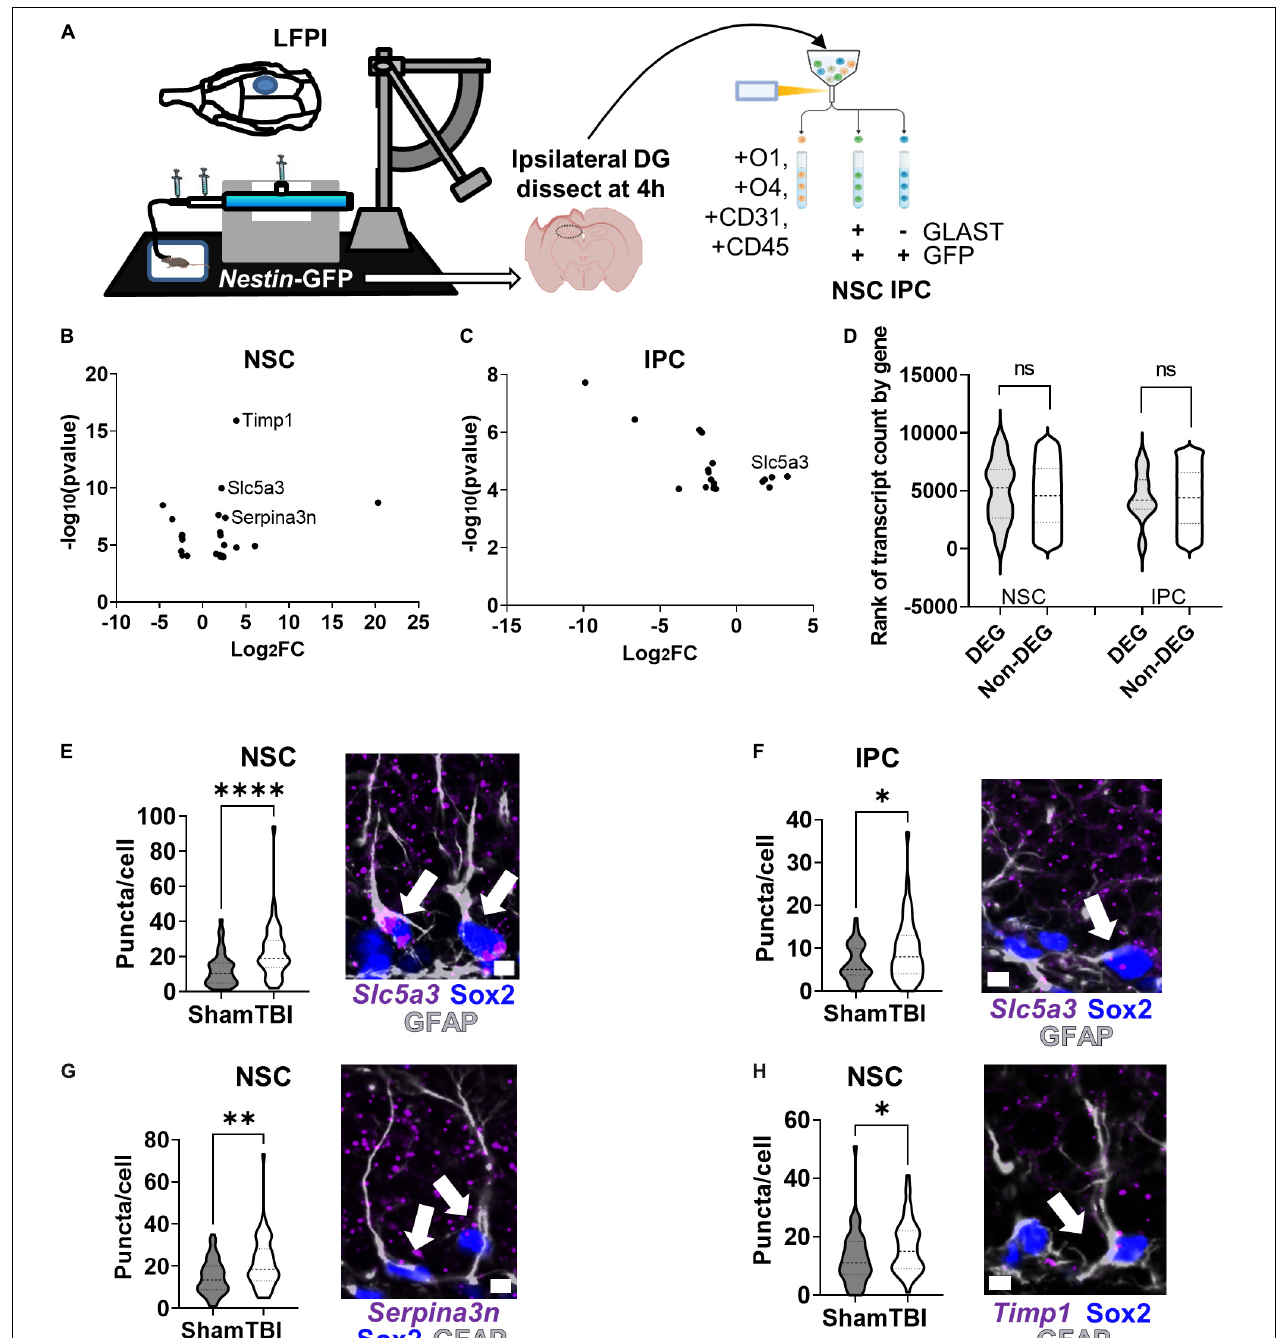
FIGURE 6 | RNAseq and CLEAR filtering enable accurate DEG identification in NSCs and IPCs in mice with lateral fluid percussive brain injury (LFPI). (A) Mice ( n = 3 per group) were given lateral fluid percussive injuries or sham treatment. Four hours after injury, DGs from the ipsilateral side of the brain were isolated and processed for RNAseq as described in Figure 5A . (B) Volcano plot of DEGs identified in NSCs after LFPI. (C) Volcano plot of DEGs identified in IPCs after LFPI. (D) Violin plot of TBI DEG and non-DEG transcript count level distribution in NSCs and IPCs. ns, not significant, Mann–Whitney test. (E) Quantification of Slc5a3 mRNA via RNAscope in NSCs (identified via GFAP + SOX2+ immunolabeling) confirmed upregulation after TBI (left). Representative image with arrows pointing to NSCs with Slc5a3 expression (right). (F) Quantification of Slc5a3 mRNA in IPCs similarly confirmed increased expression after LFPI (left). Representative image with arrow pointing to IPC with Slc5a3 expression (right). (G) Quantification of Serpina3n mRNA in NSCs also confirmed upregulation after LFPI (left). Representative image with arrow pointing to NSC with Serpina3n expression (right). (H) Quantification of Timp1 mRNA in NSCs also showed increased expression after LFPI (left). Representative image with arrow pointing to NSC with Timp1 expression (right). (E–H) Mean ± SEM of mean RNA puncta per cell with n = 50 cells per group from 5 mice, Mann–Whitney t -test, ∗ p < 0.05, ∗∗ p < 0.01, ∗∗∗∗ p < 0.0001 . Scale bars = 5 µ m.